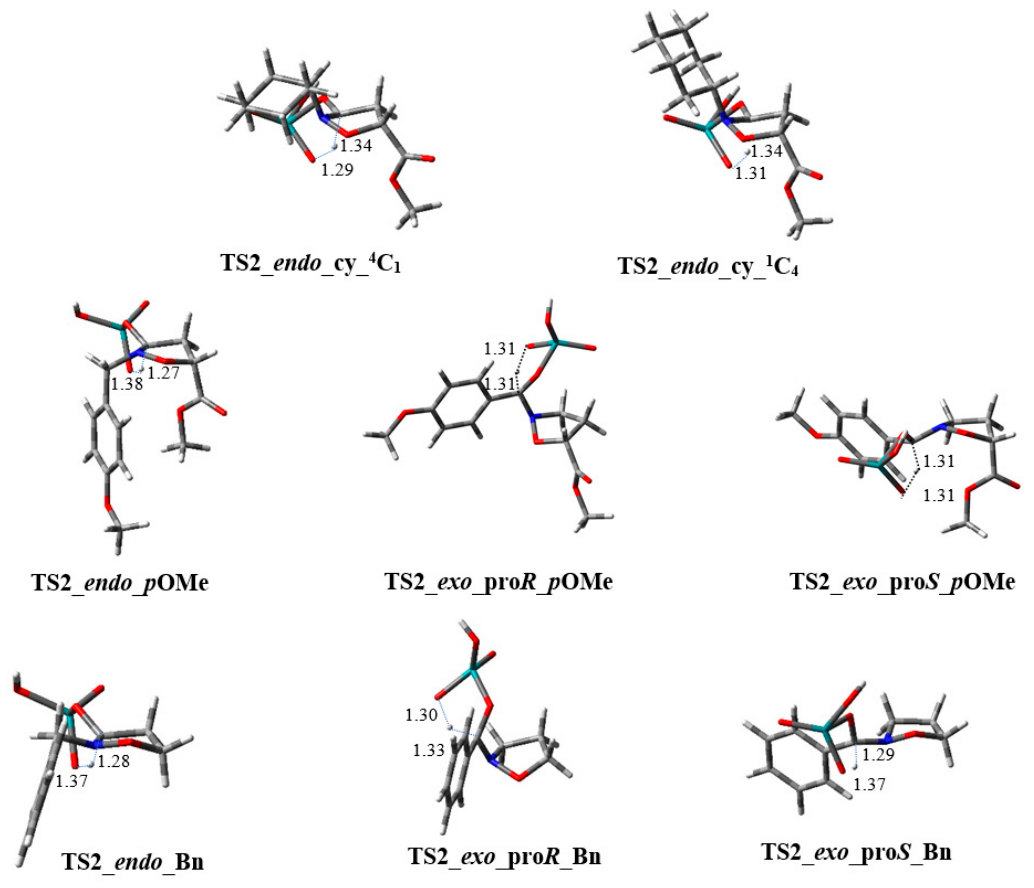
frequencies are shown as dotted lines and distances are reported in angstroms.